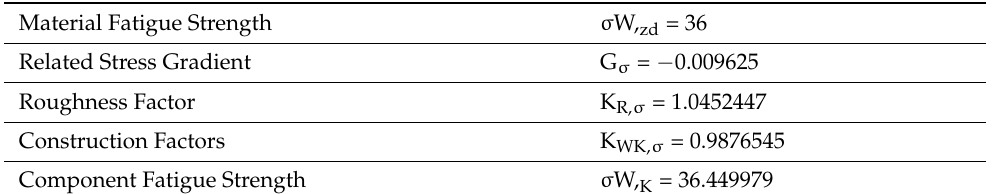
Table 5. Intermediate results of calculations (composition No. 15).